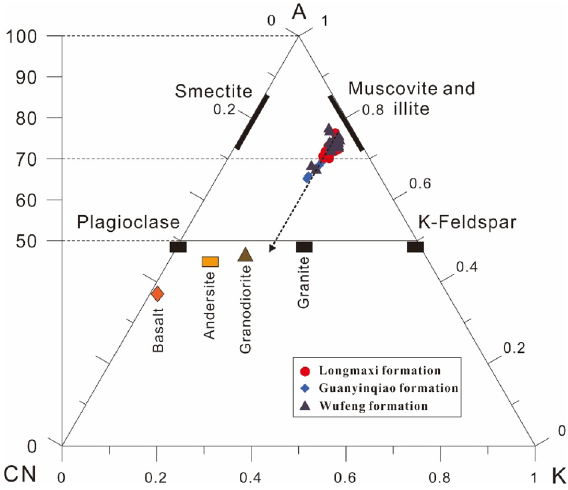
Figure 12. Al 2 O 3 –CaO * + Na 2 O–K 2 O ternary diagram for shales and carbonaceous marls of the Wufeng- Longmaxi Formations in the Xindi No. 2 well (after Nesbitt and Young 91